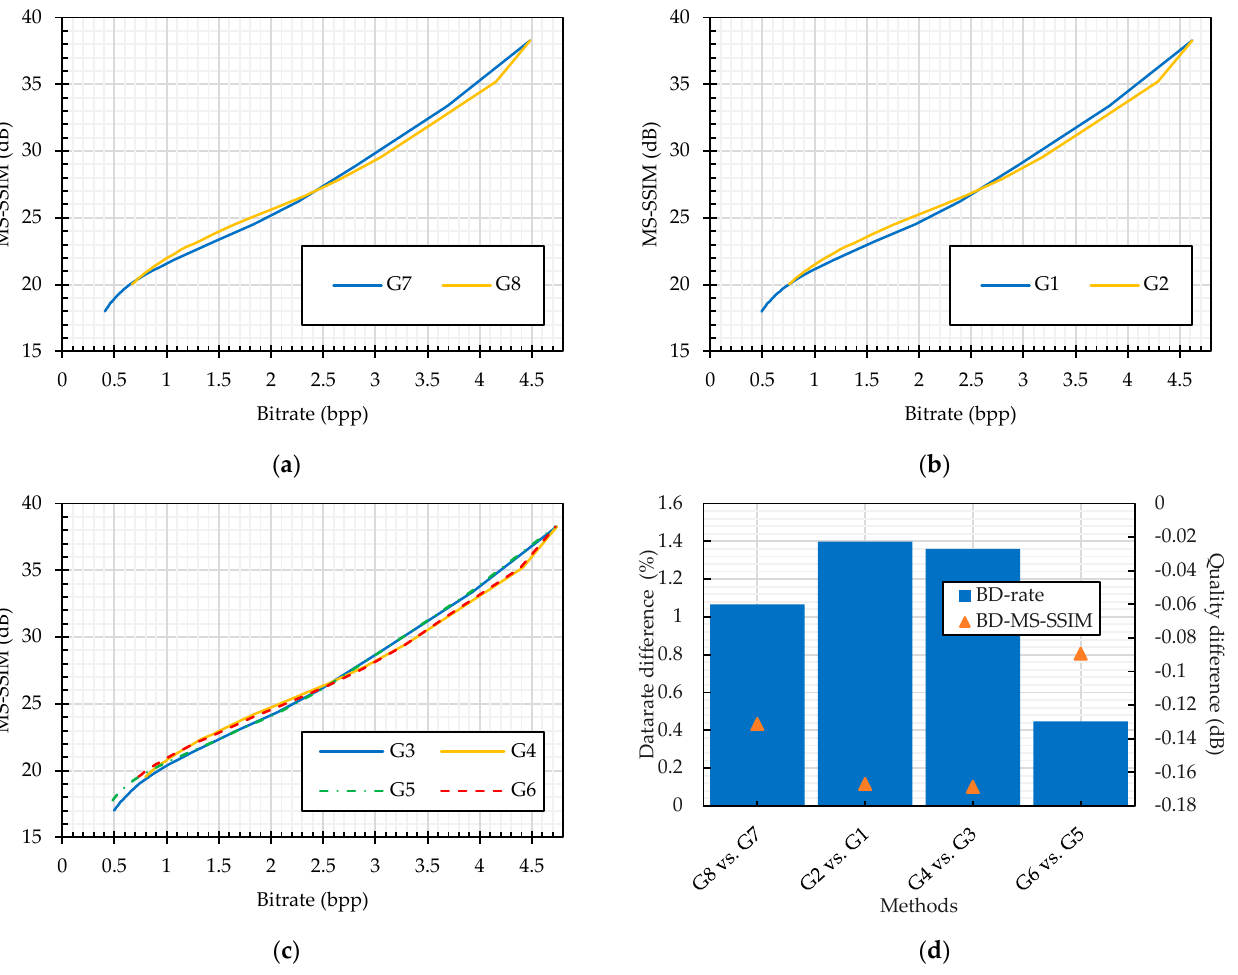
Figure 18. The JPEG compression analysis of plain and CPE grayscale images with respect to the quantization table choice. ( a ) Plain image compression ( b ) CPE schemes that perform entire block processing. ( c ) CPE schemes that perform sub-block processing. ( d ) The BD-measures plot.